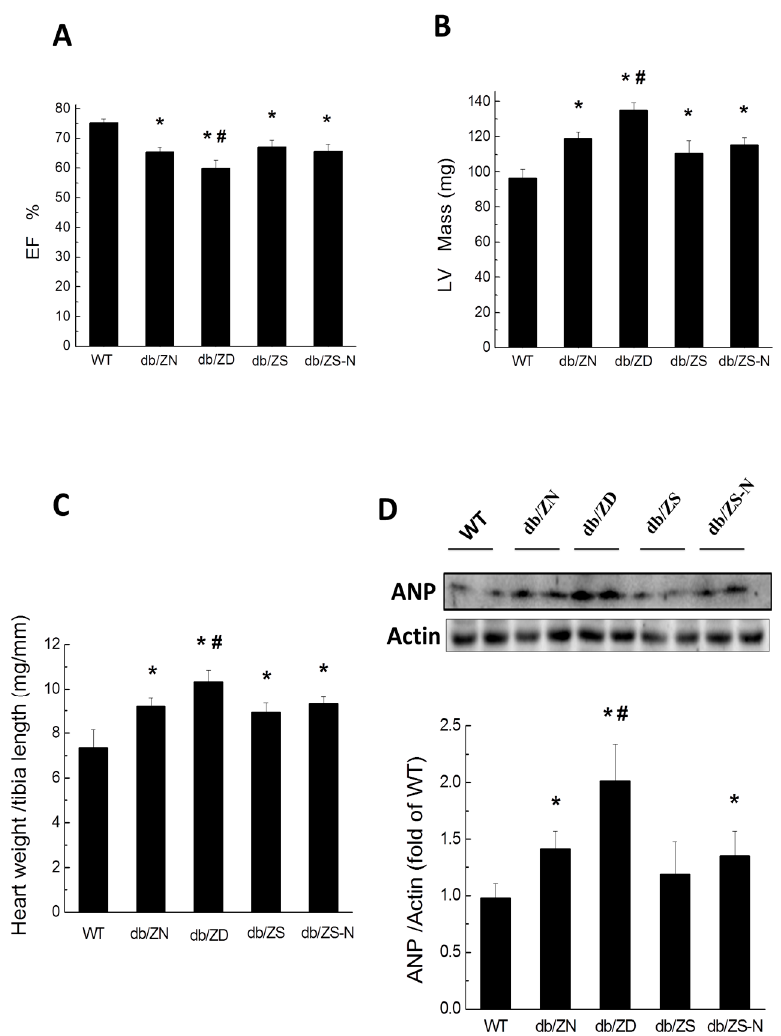
Figure 2. Zn deficiency exacerbates diabetic-induced heart hypertrophy and function. Animals were treated as described in Figure 1. EF% ( A ) and corrected Left ventricular (LV) mass (mg/g) ( B ) were examined by echocardiography. Heart-weight to tibial length ratio ( C ) and atrial natriuretic peptide (ANP) protein levels obtained by Western Blot ( D ) were assessed as indicators of heart hypertrophy and function. Data were presented as mean ± SD ( n = 4–7, details in Figure 1). *, p < 0.05 vs. WT group; #, p < 0.05 vs. db/ZN group.